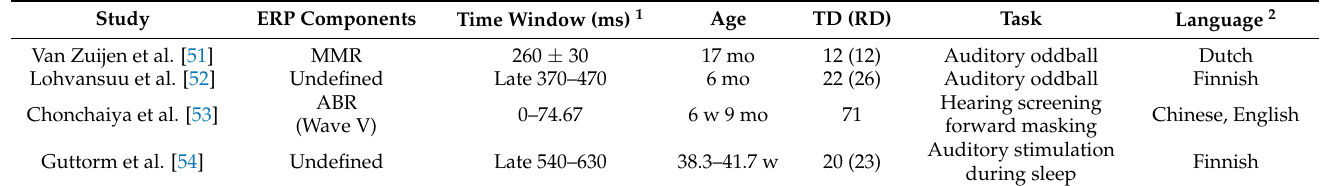
Table 1. Overview of the publications selected for review; studies with infants and toddlers.